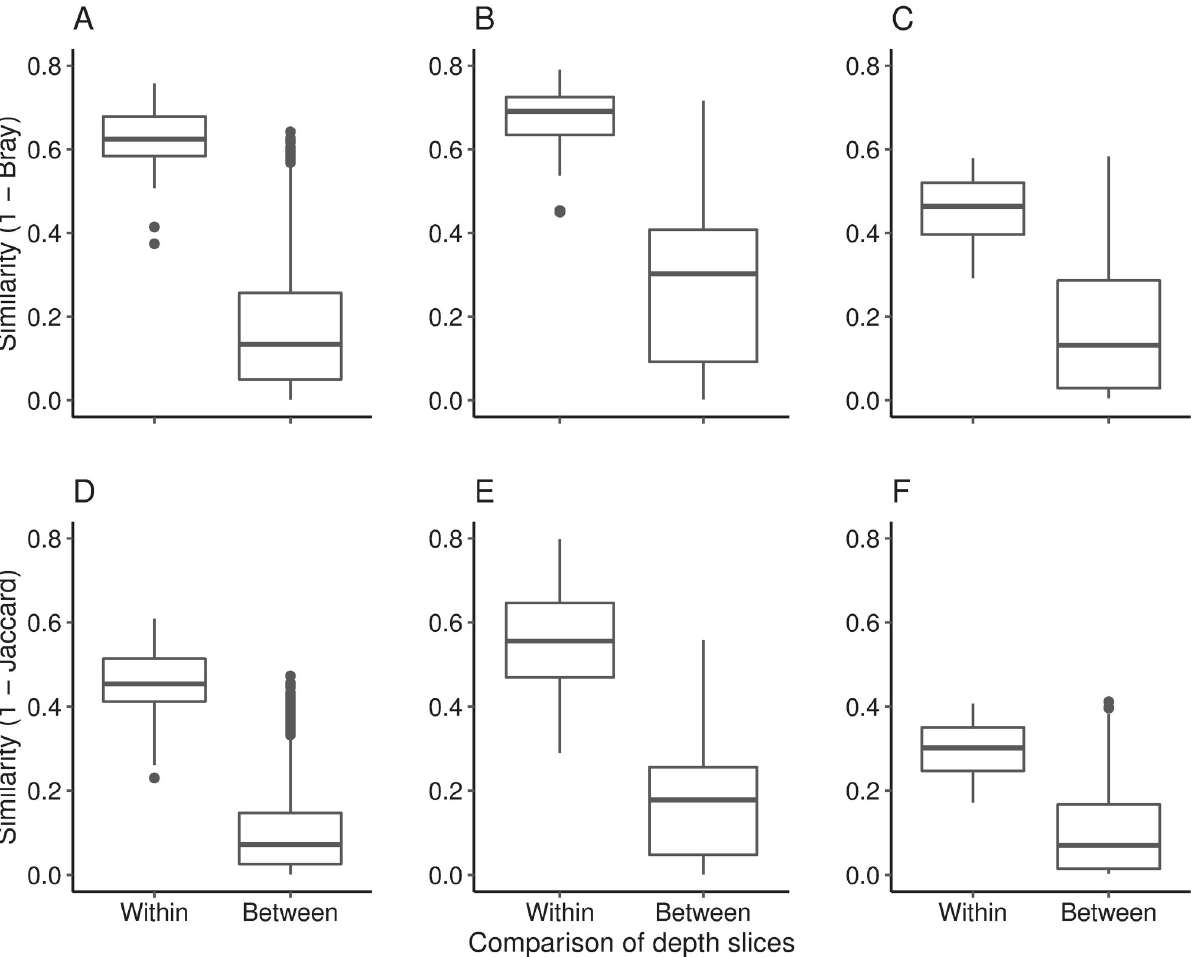
Fig 2. Similarity comparisons (1—Bray Curtis distance) within and between depth slices for Lake Nganoke (A), Lake Paringa (B), and Lake Pounui (C). Similarity comparisons (1—Jaccard distance) within and between depth slices for Lake Nganoke (D), Lake Paringa (E), and Lake Pounui (F). Boxes display the first and third quartile spread of the data, with the line in the box indicating the median, the whiskers denoting the minimum and maximum values and the dots as outliers of the data.